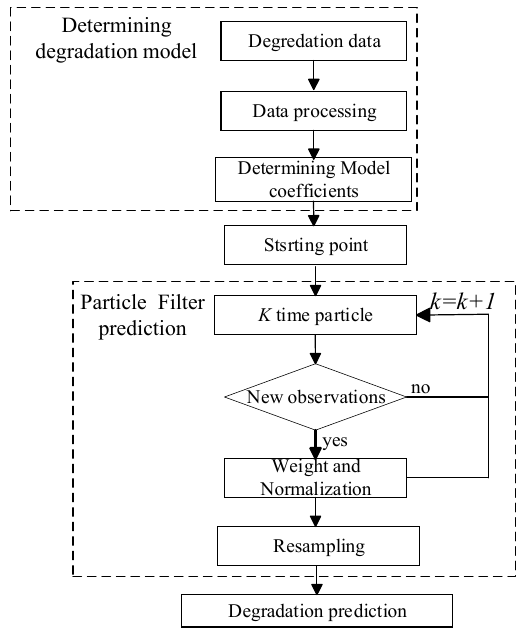
Figure 11. Prediction flow chart based on particle filtering.